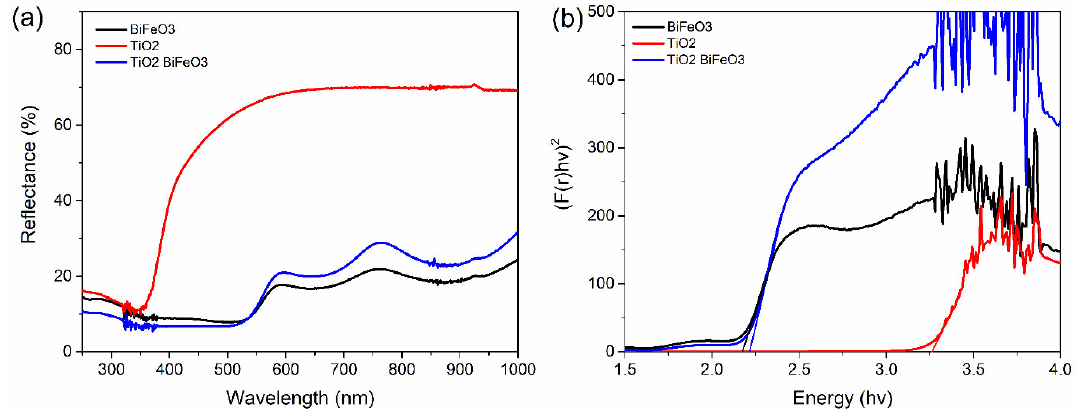
Figure 4. Optical properties of BiFeO 3 ( a ) absorption spectrum, ( b ) Kubelka–Munk function for bandgap calculation.